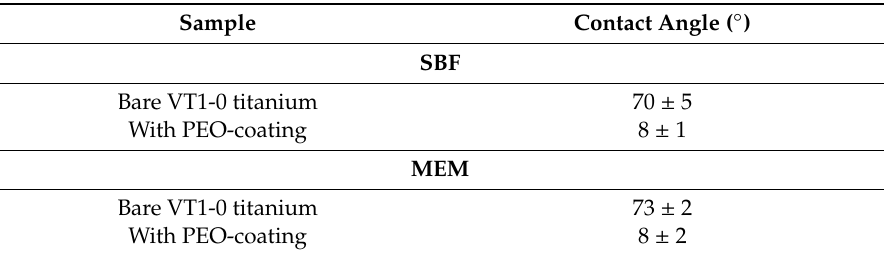
Table 6. Wettability of the samples with di ff erent types of surface treatment.